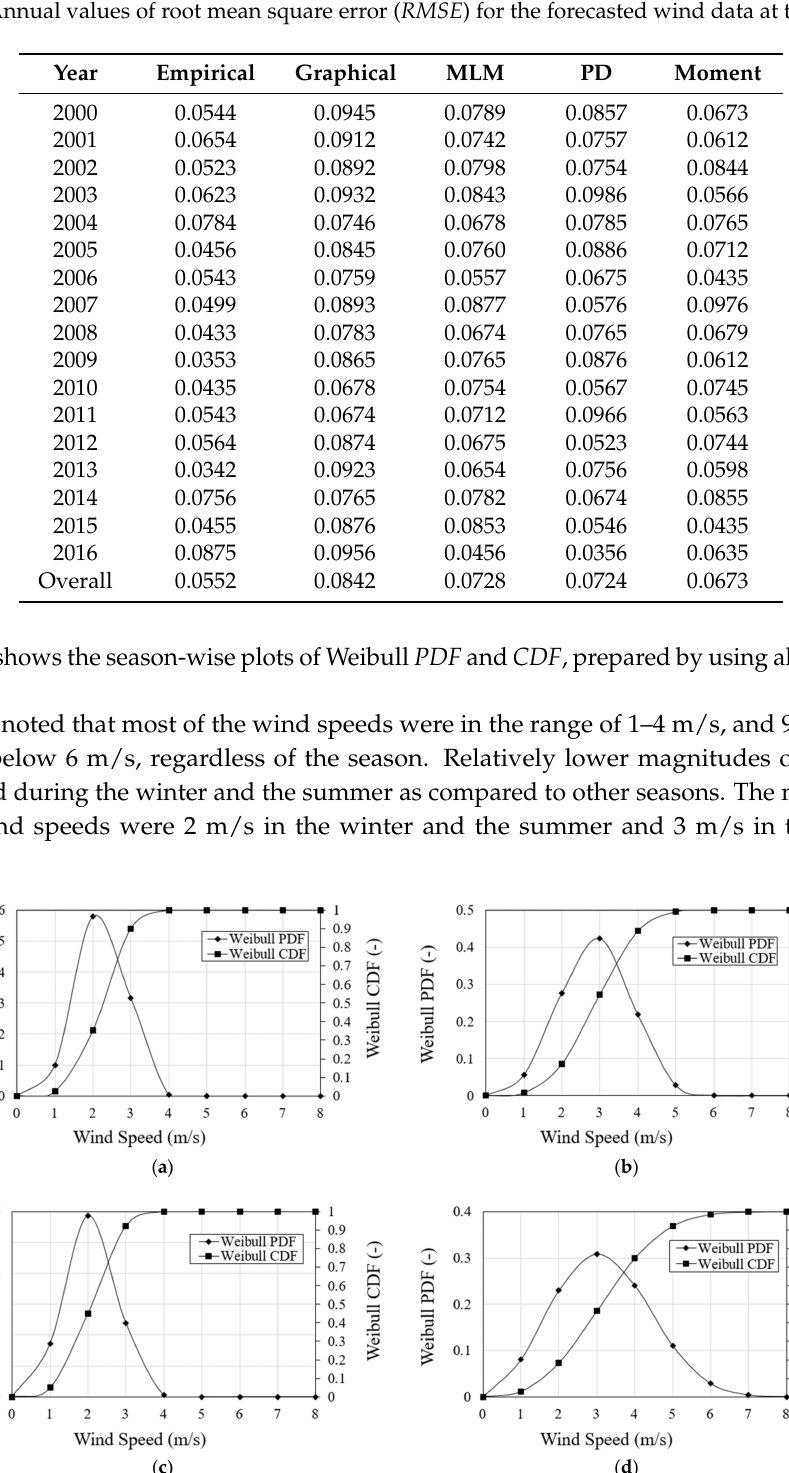
Table 5. Annual values of root mean square error ( RMSE ) for the forecasted wind data at the test site.